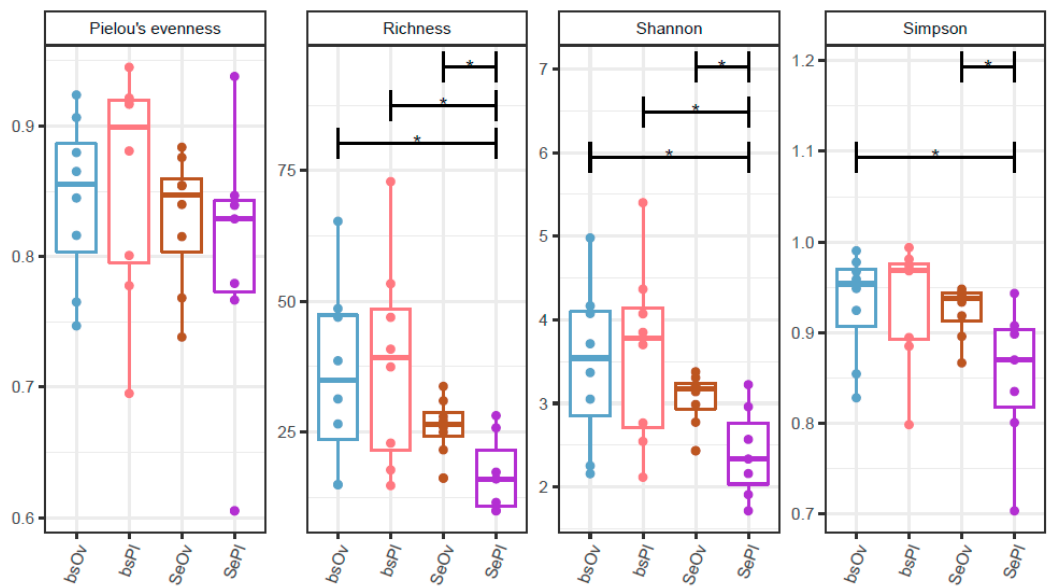
Figure 4. The species richness and diversity indexes of the bulk soil and seed endophytes of N. caerulescens from Overpelt and Plombières, Belgium. (* p < 0.05, ANOVA).